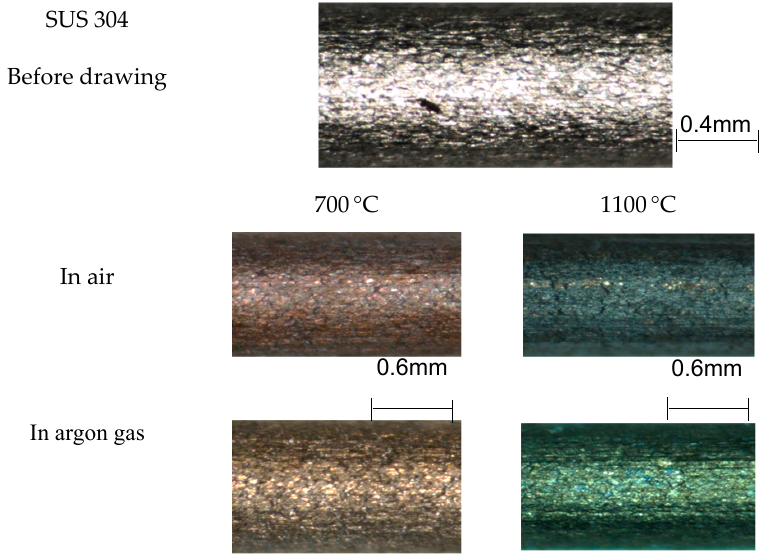
Figure 4. Appearance of stainless steel wire surfaces under different forming conditions.